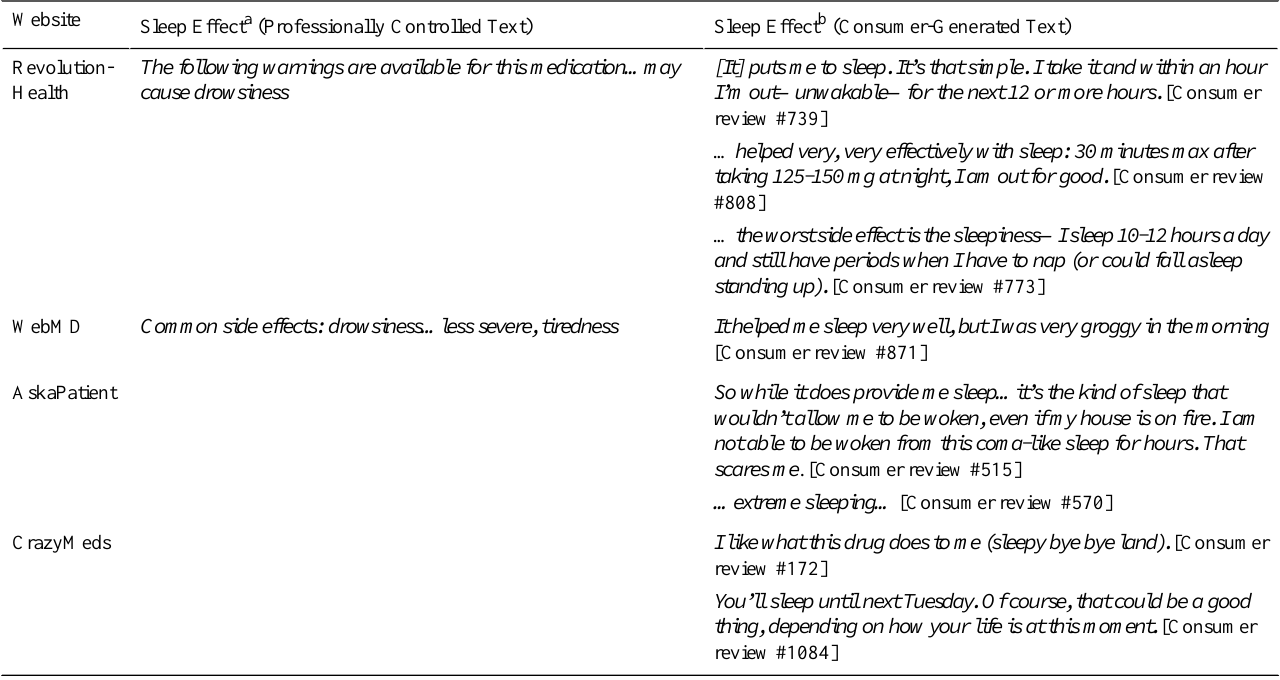
Table 7. Sleep effects of quetiapine according to consumer-generated and professionally controlled